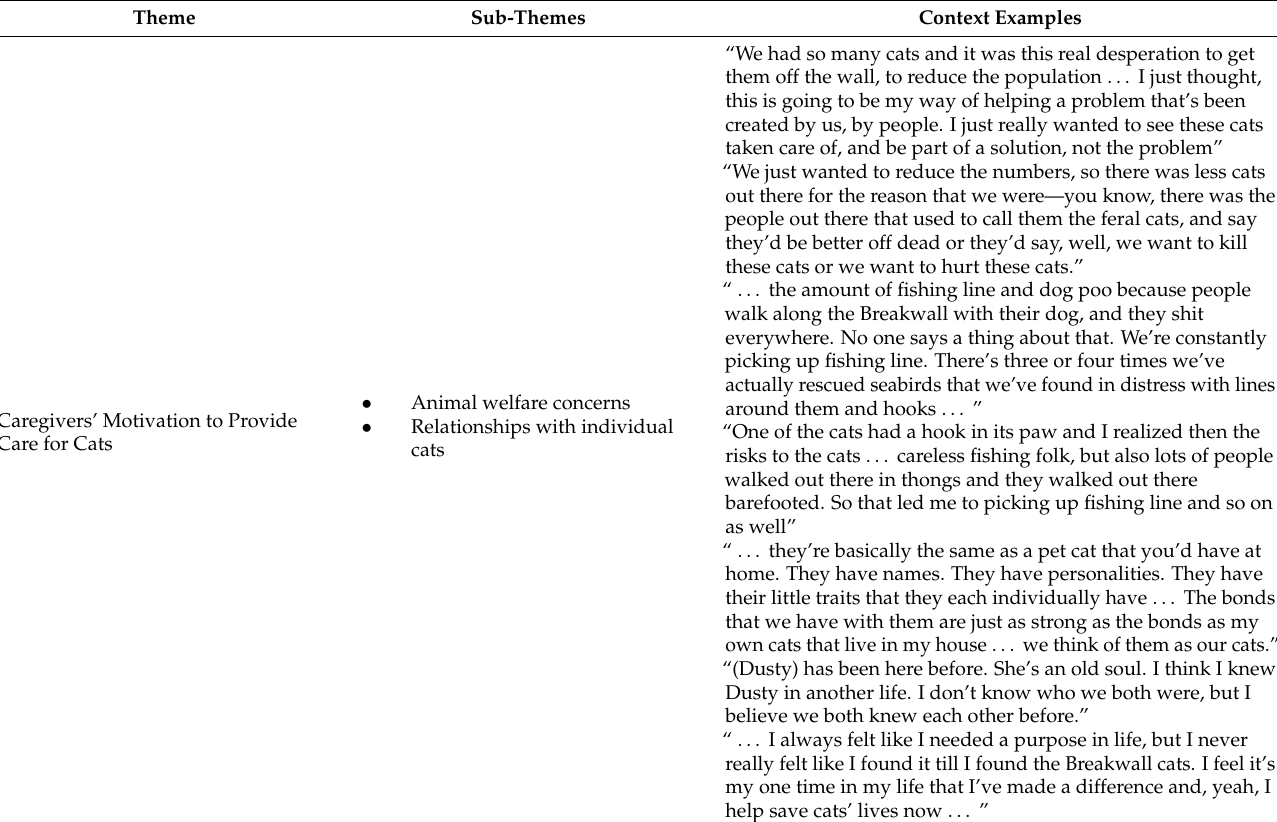
Table 2. Major themes and sub-themes with context examples from interview